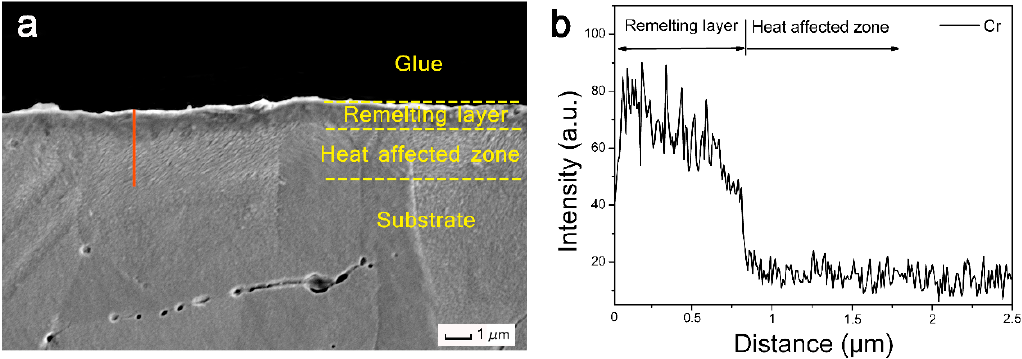
Figure 3. ( a ) A cross-section SEM image and ( b ) EDS line scanning analysis of the 20-pulse HCPEB-irradiated Cr–Ni sample.